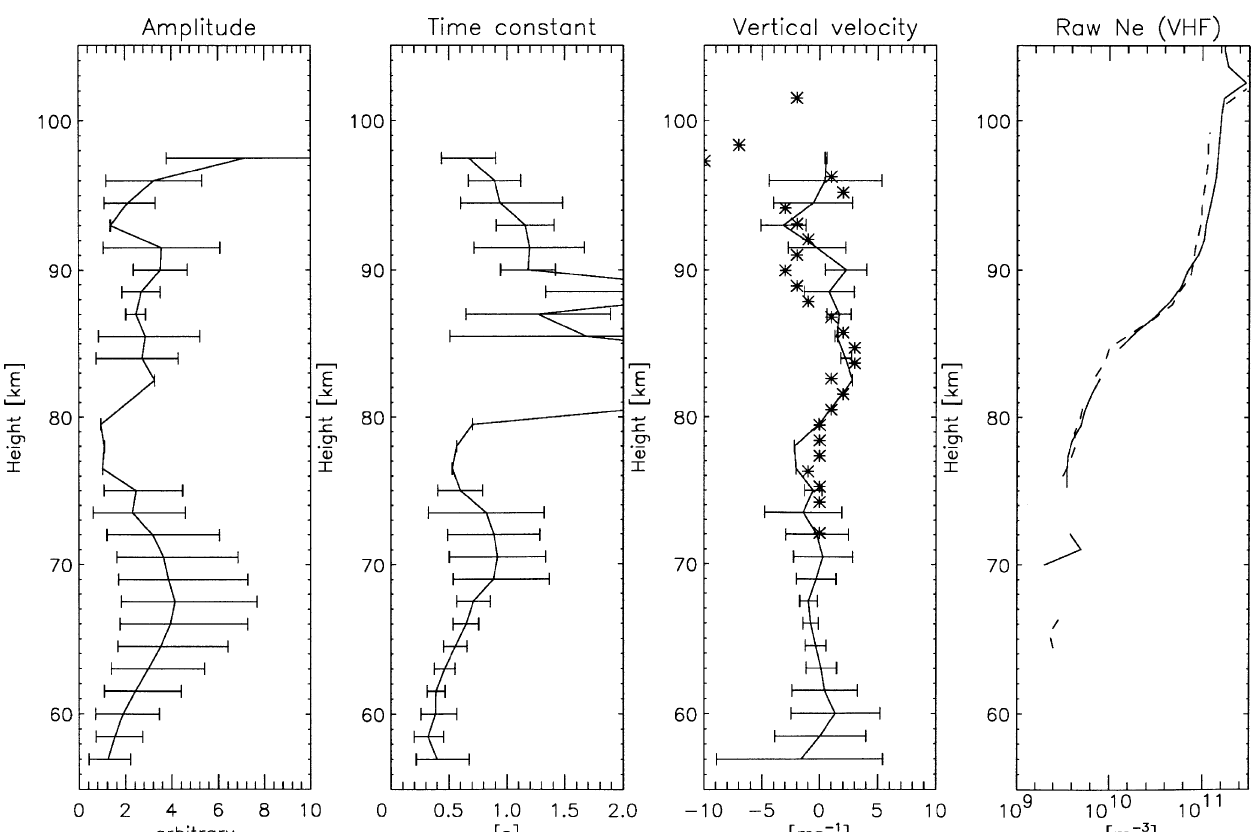
as are the raw electron densities in the right - hand panel . The densities shown by the solid line are from a vertical antenna position (1220 — 1230 UT), while those shown by the dashed line are from an elevation 67 ° to the north (1240 — 1250